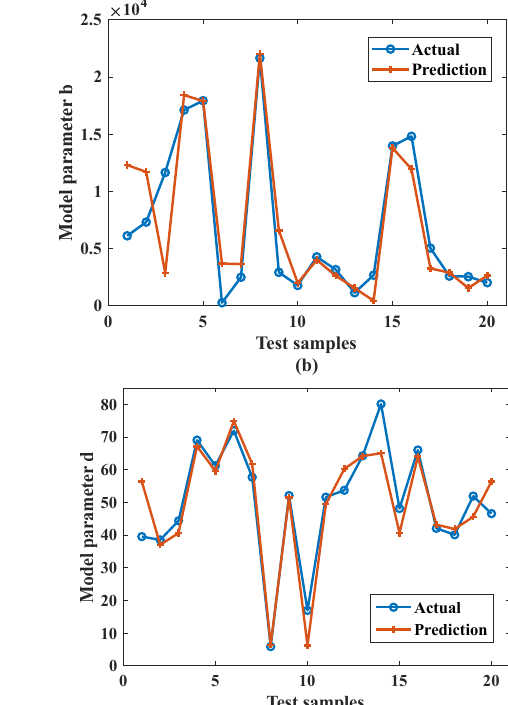
Table 5. The parameters of the particle swarm optimization.